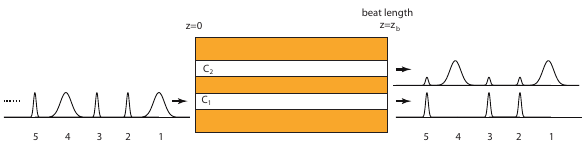
Figure 3. Sketch of the device operation to discriminate di ff erent time-width